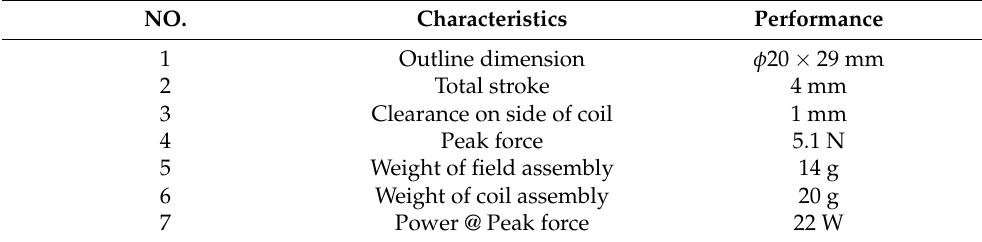
Table 4. Performances of linear voice coil motor. NO.